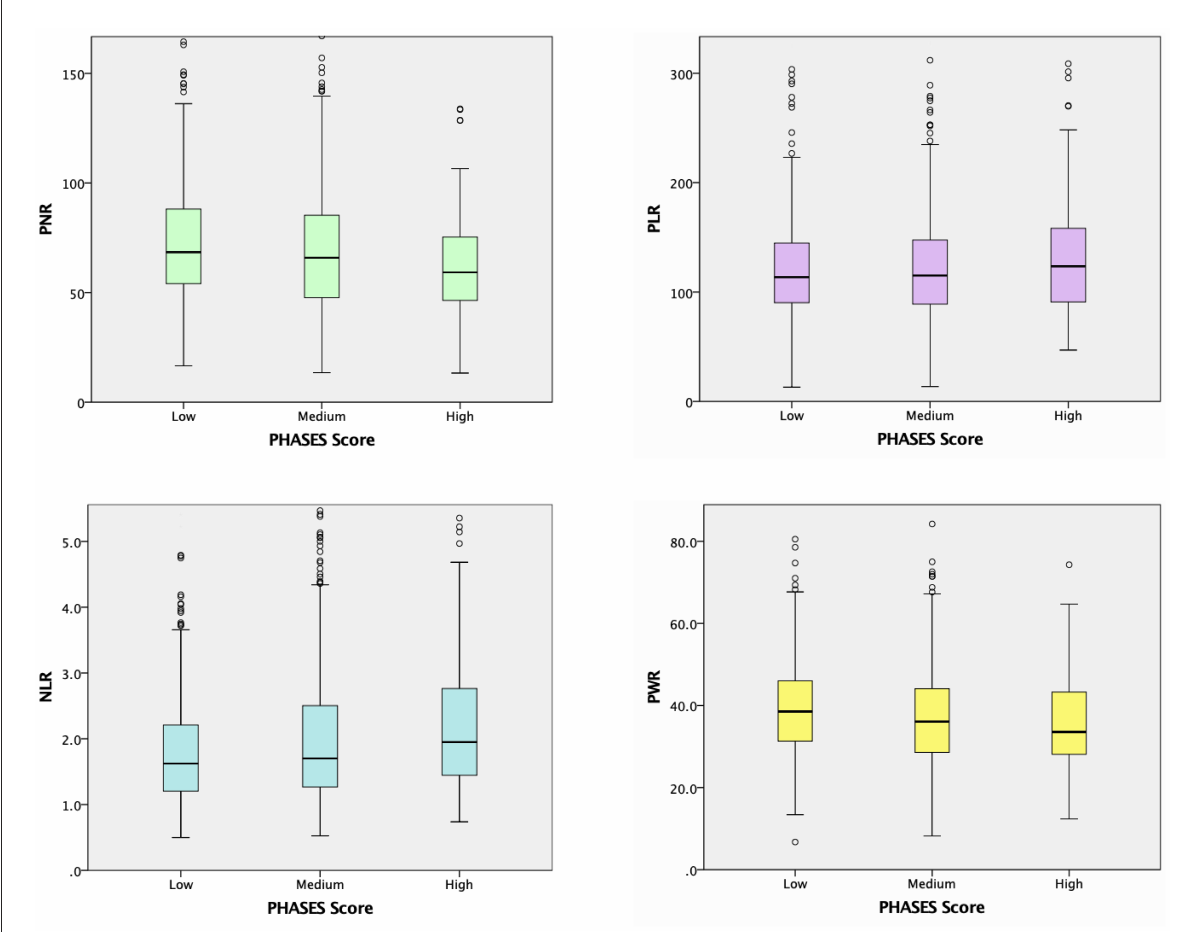
FIGURE2 Boxplots of the peripheral blood cell ratios according to PHASES scale